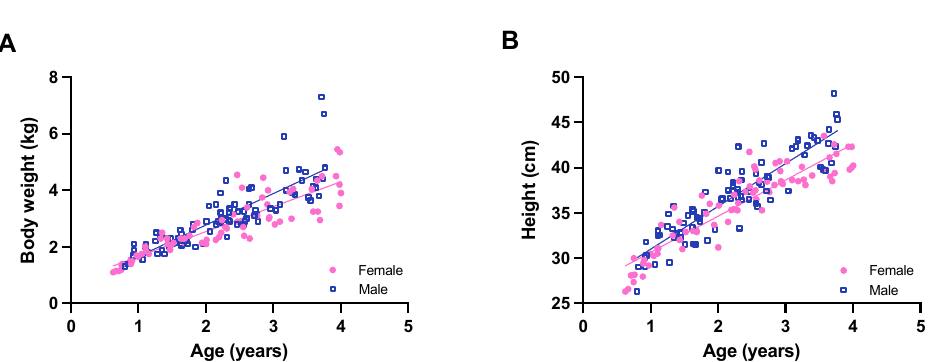
Figure A1. Growth patterns of immature male and female long-tailed macaques based on body weight ( A ) and height ( B ). The steeper blue line implies that the growth rate of immature males is higher compared to females.